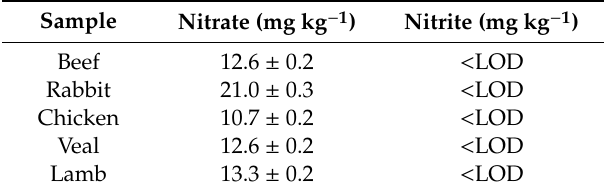
Figure 3. Comparison of five IC-CD chromatograms of samples prepared by homogenized lamb, rabbit, veal, beef and chicken meats. The expanded view shows each chromatographic profile. Table 2. The concentrations of nitrates and nitrites (mg kg − 1 ), occurring in five homogenized meat samples, marketed in Italy. Values represent the means ± expanded uncertainty at 95% confidence level of n = 3 triplicate measurements (independently repeated experiments).